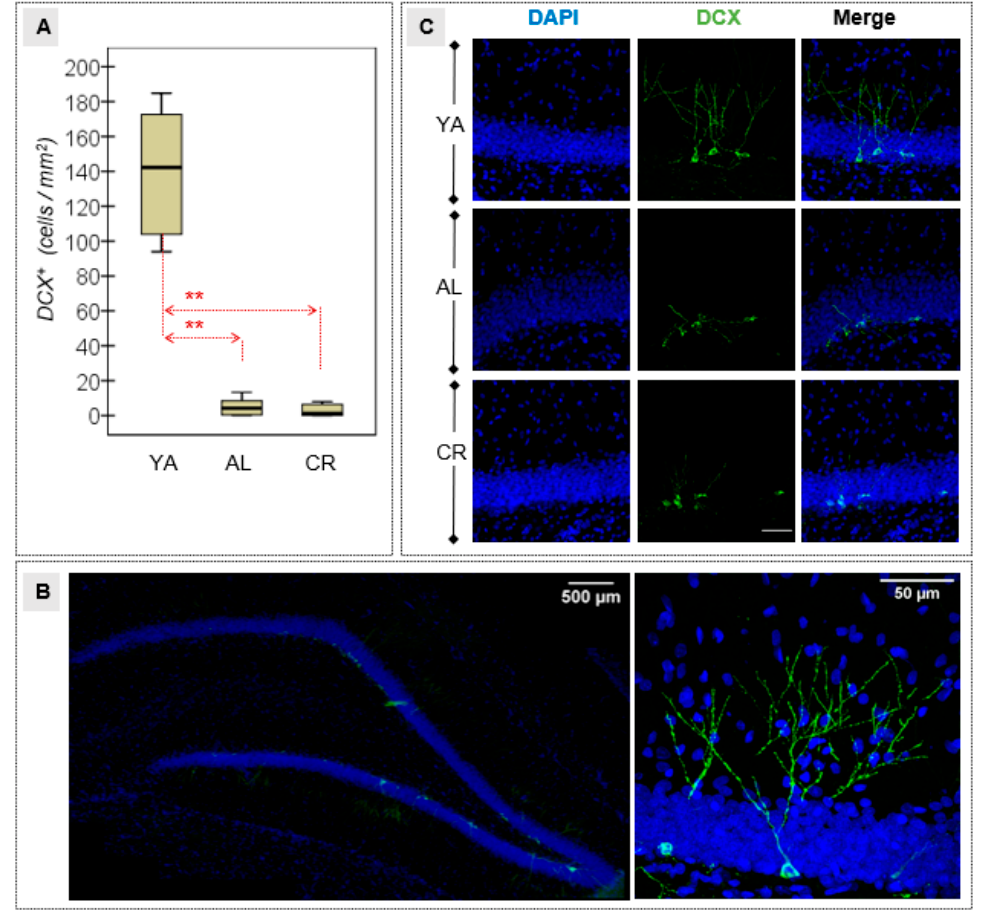
Figure 5. ( A ) Quantification of the immature neurons in the DG, as represented by the proportion of DCX+ cells in the hippocampal area. ( B ) DCX immunostaining in the DG of YA and older rats: a representative image of the hippocampal DG with a high magnification (inset) of a DCX+ cell from a YA animal. ( C ) Representative micrographs of DCX+ immature neurons in the DG (green) to illustrate the analysis, with the nuclei stained with DAPI (blue). Scale bar = 50 µ m. YA, young adult (top); AL, ad libitum (middle); CR, caloric restriction (bottom); ** Large–high effect size (| d | > 0.80).